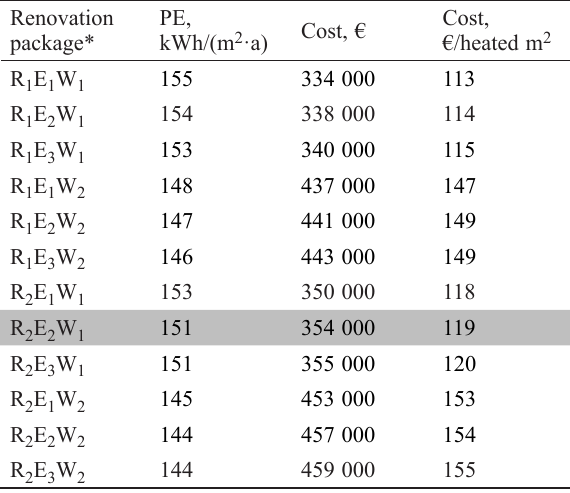
Table 3. Analysed renovation packages (grey shaded is the realised renovation packages)